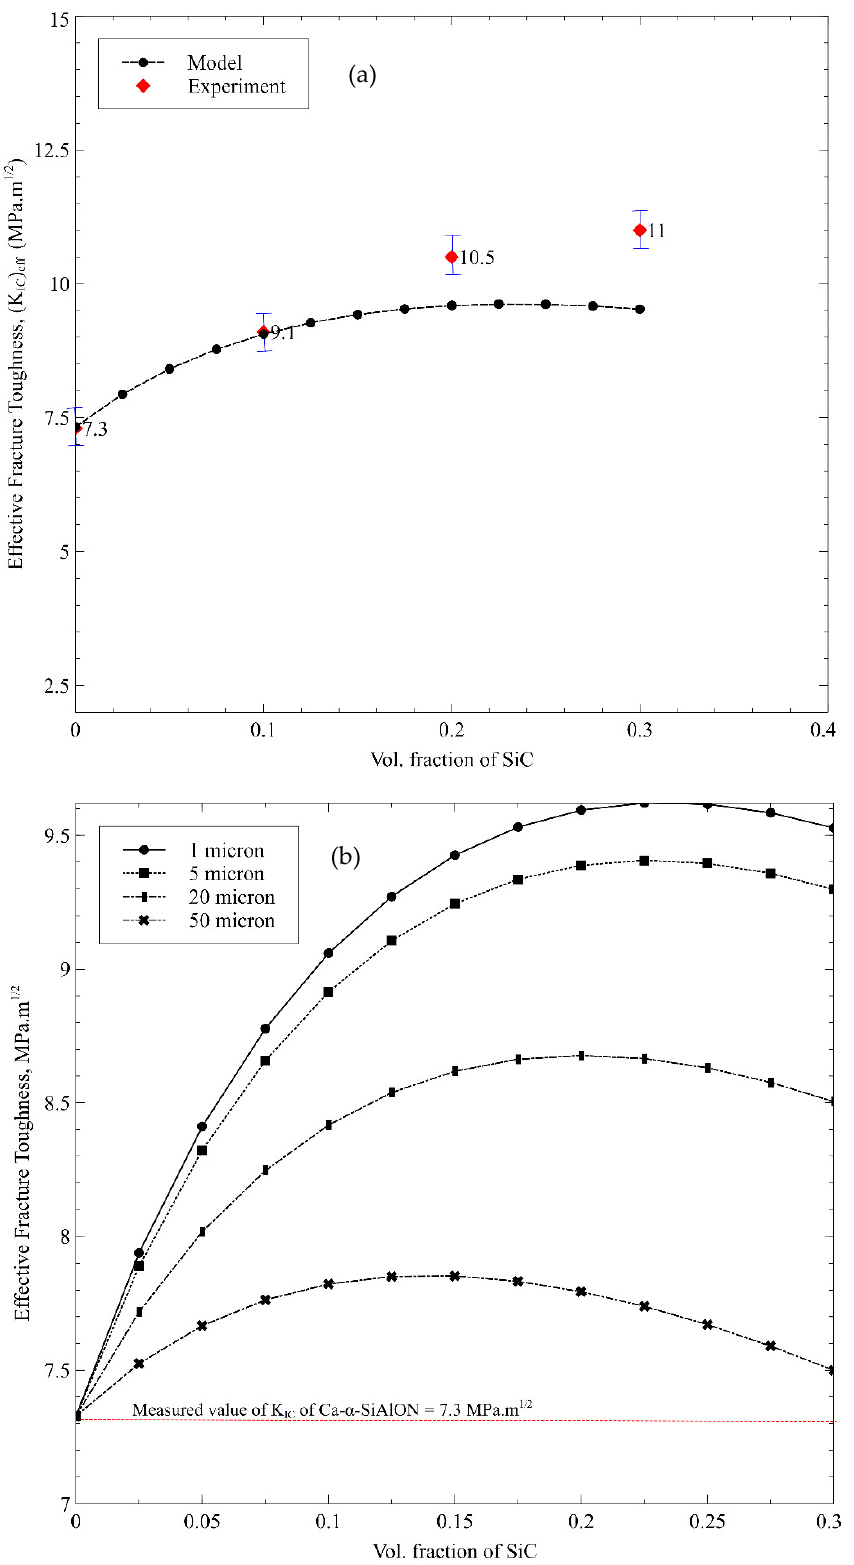
Figure 10. ( a ) Predicted and measured fracture toughness of the Ca- α -SiAlON/SiC composite for different compositions. A SiC particle size of 2 µm was used in synthesized composites, ( b ) Variation of effective fracture toughness of Ca-α-SiAlON/SiC composite as a function SiC particle size and volume fraction.